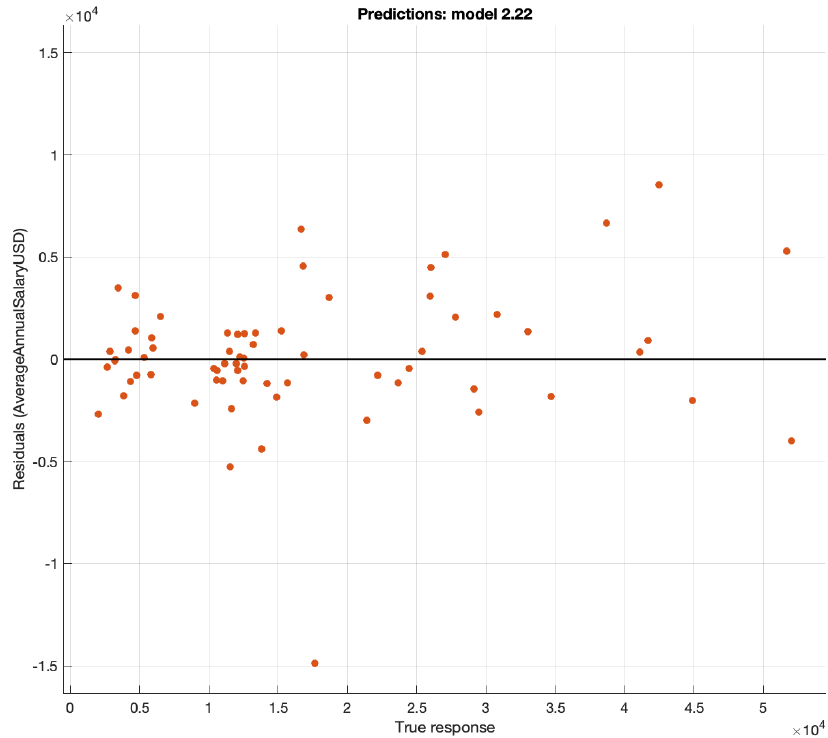
Figure 6. Residual errors plot for ANN regression across occupations